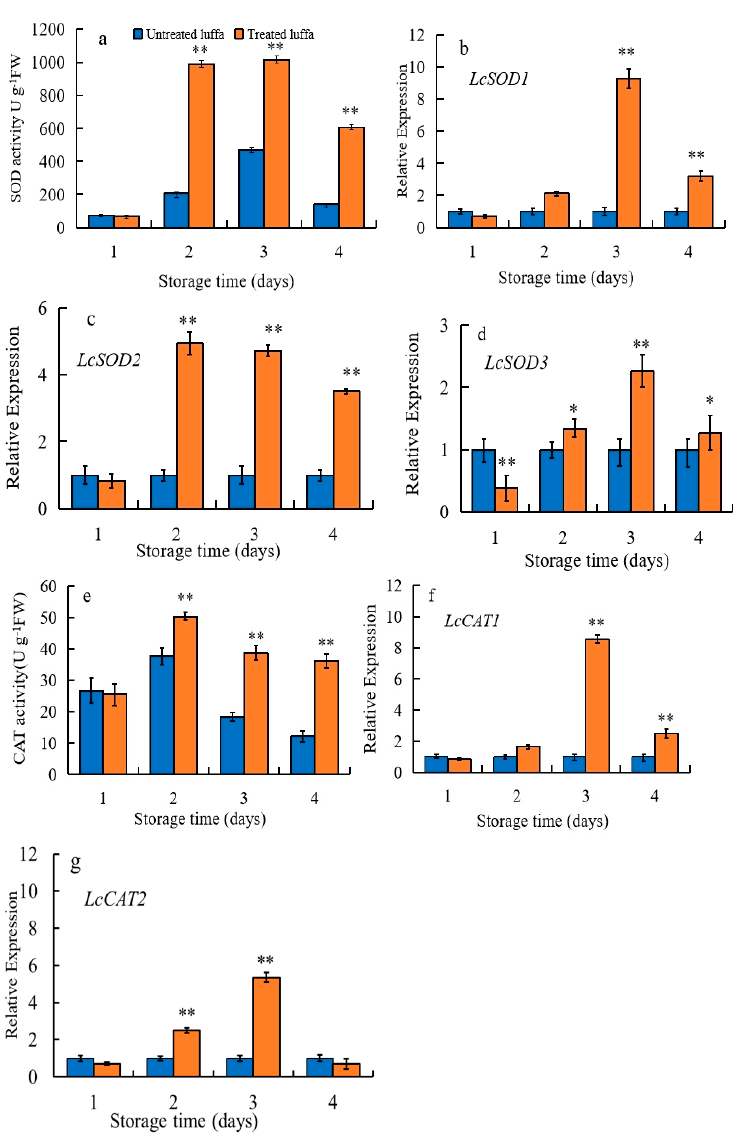
Figure 5. Effect of CaCl 2 treatment on antioxidant enzyme activity and related gene expression